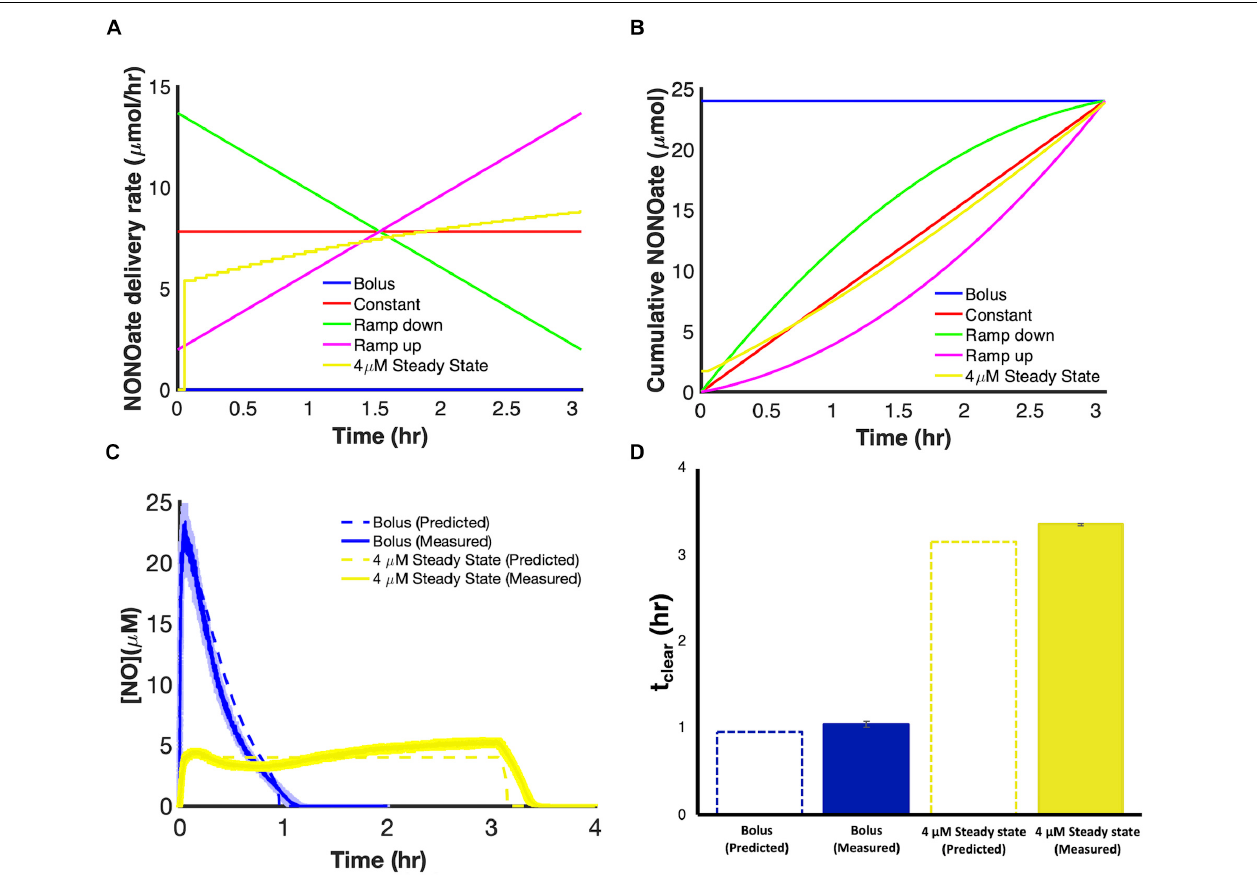
FIGURE 8 | Implementation of a delivery schedule to maintain [NO] at 4 µ M steady state with a payload of 24 µ mol. Comparison of delivery rate (A) and cumulative NONOate (B) profiles for a 4 µ M steady state dosing schedule and the principle delivery modes over identical delivery periods. Comparison of the predicted and measured [NO] profiles (C) and t clear values (D) for a 4 µ M steady state dosing scheme compared to a bolus delivery. Dashed colored lines represent predicted [NO] dynamics using the optimal parameter set (ER = 1, minimum SSR, 1 set). Solid colored lines represent the mean of three independent experiments, while lightly shaded areas represent the standard error of the